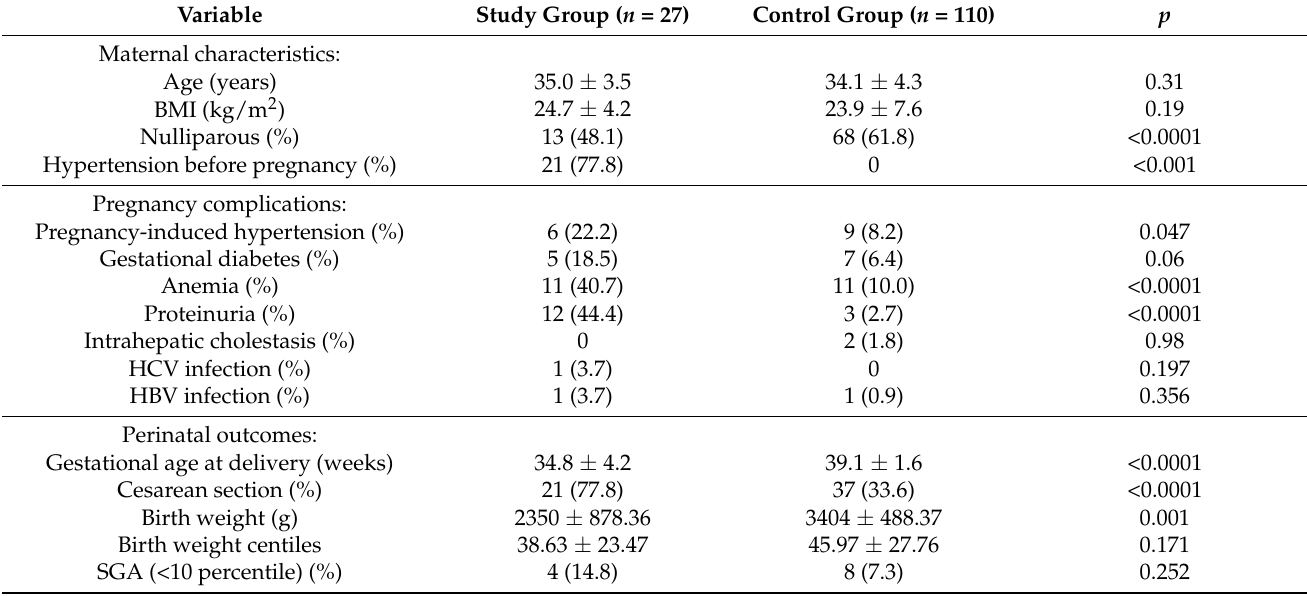
Table 1. Characteristics of study and control